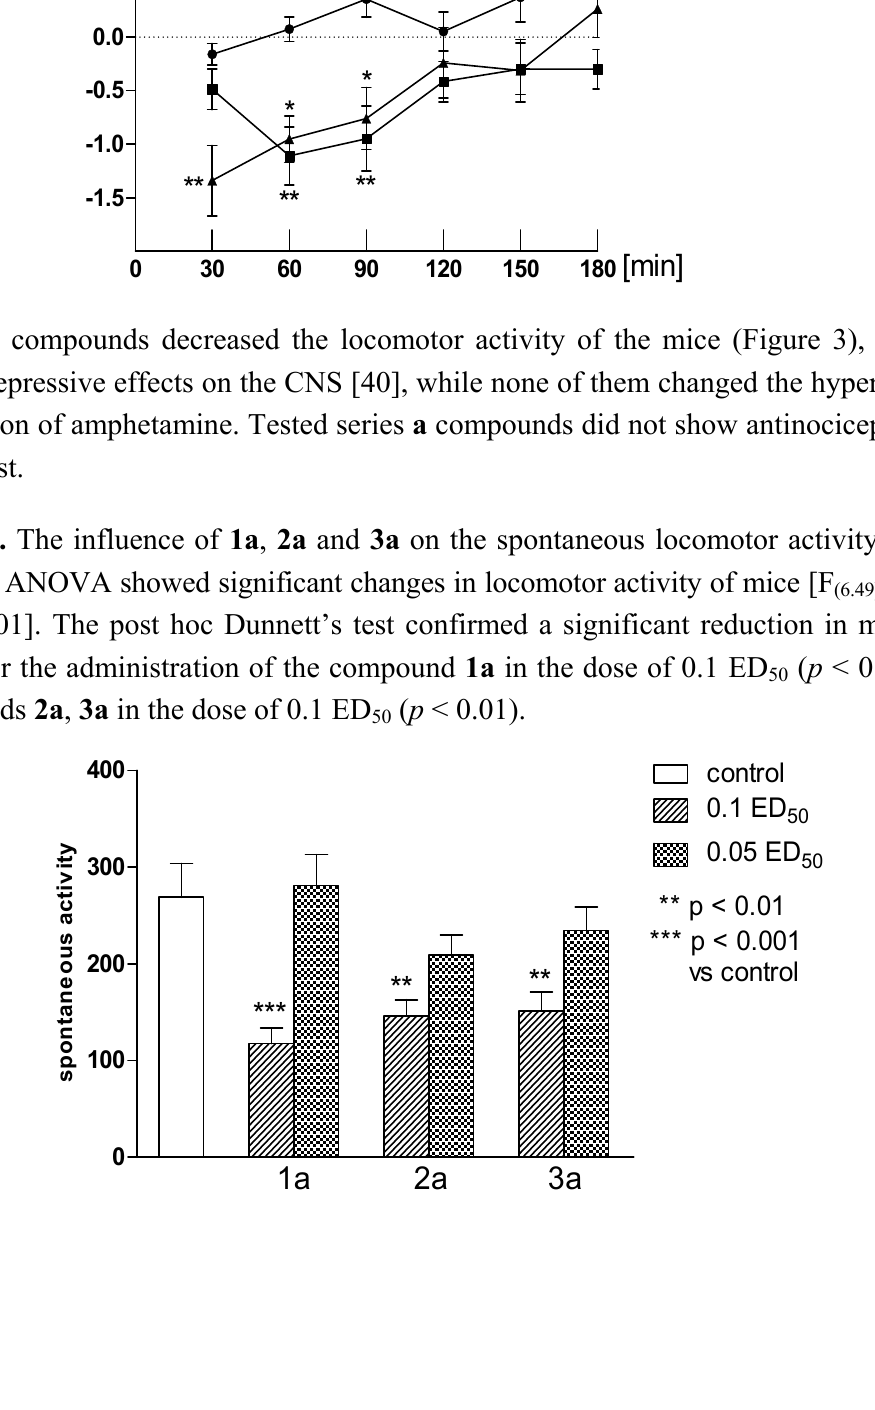
Figure 2. The influence of compound 2a and 3a (used in a dose of 0.1 ED temperature of the mice. Two-way ANOVA revealed significant effects for both compounds [F = 22.14; p < 0.0001] and time [(F (2.142) interaction [F = 1.57; p = 0.122]. Post hoc Bonferroni test confirmed a significant (10.142) decrease in the body temperature of the mice after the administration of compound 2a in the dose of 0.1 ED in 60 and 90 min ( p < 0.001), and compound 3a in the dose of 50 0.1 ED in 30 min ( p < 0.001), 60 and 90 min ( p < 0.05). 50